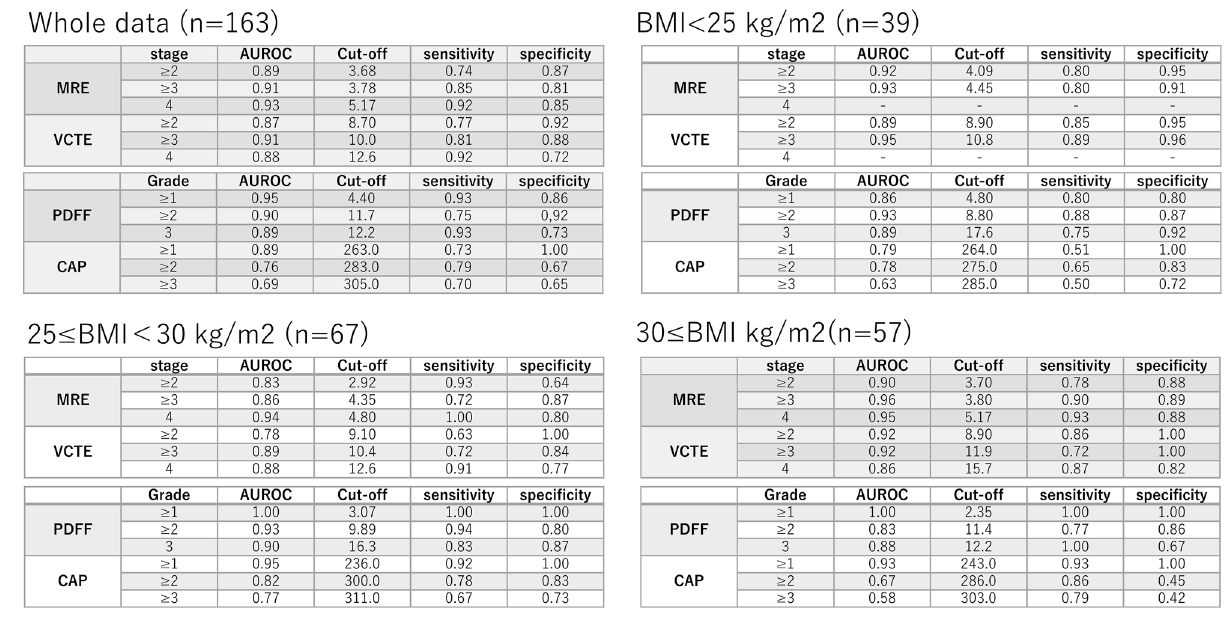
Figure 5. Comparison of the diagnostic accuracy of VCTE and MRI/MRE techniques to detect liver steatosis in patients with NAFLD presented by AUROCs. MRE magnetic resonance elastography, MRI magnetic resonance imaging, VCTE vibration-controlled transient elastography, AUROC area under the receiver operating curve.